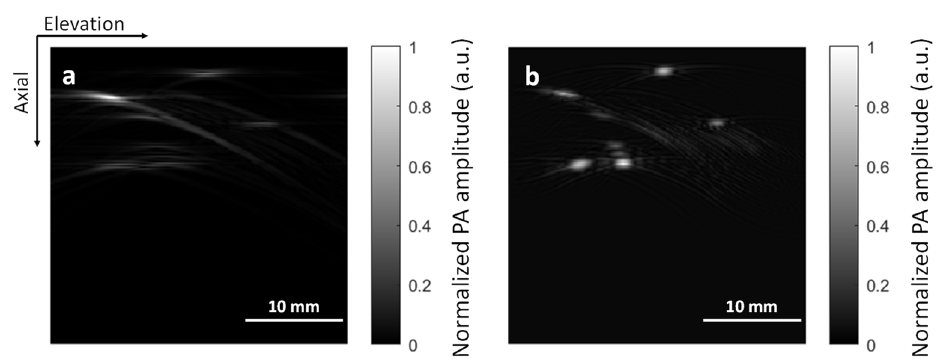
Figure 2. Comparison of axial-elevation plane images obtained from ( a ) the 2D stack reconstruction algorithm and ( b ) the virtual point detector reconstruction algorithm.